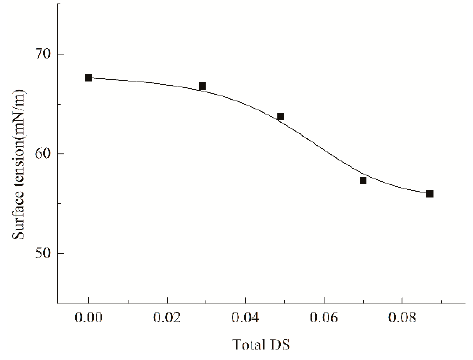
Figure 5. Impact of the caproates and PSH substituents on the surface tension of cooked starch paste.